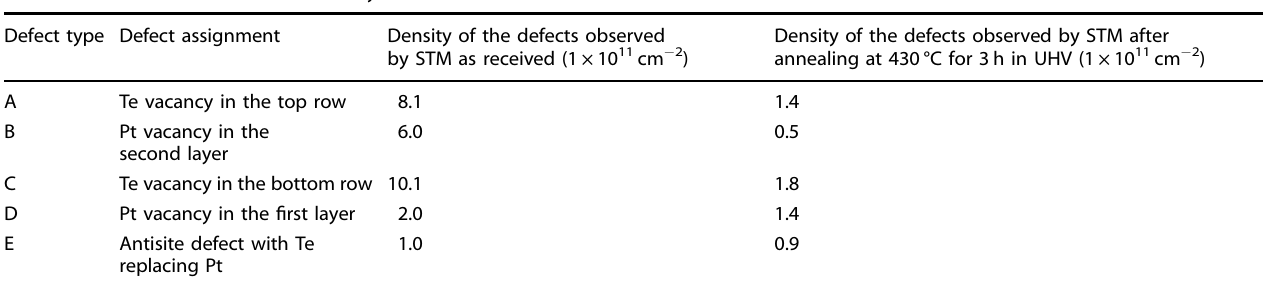
Table 1. Densities of defects measured by